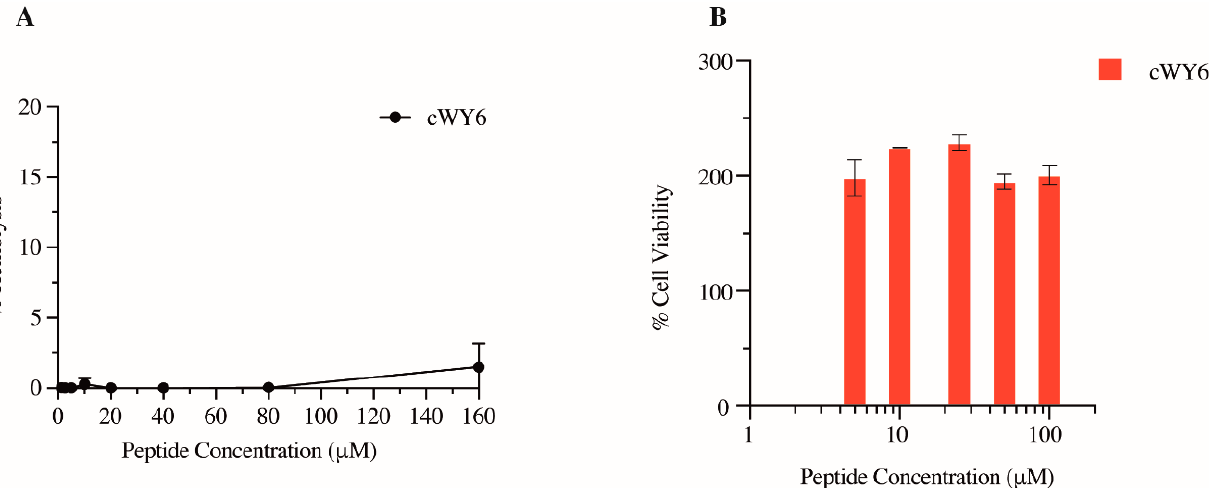
fibroblast NIH3T3 cells (Figure 6B).